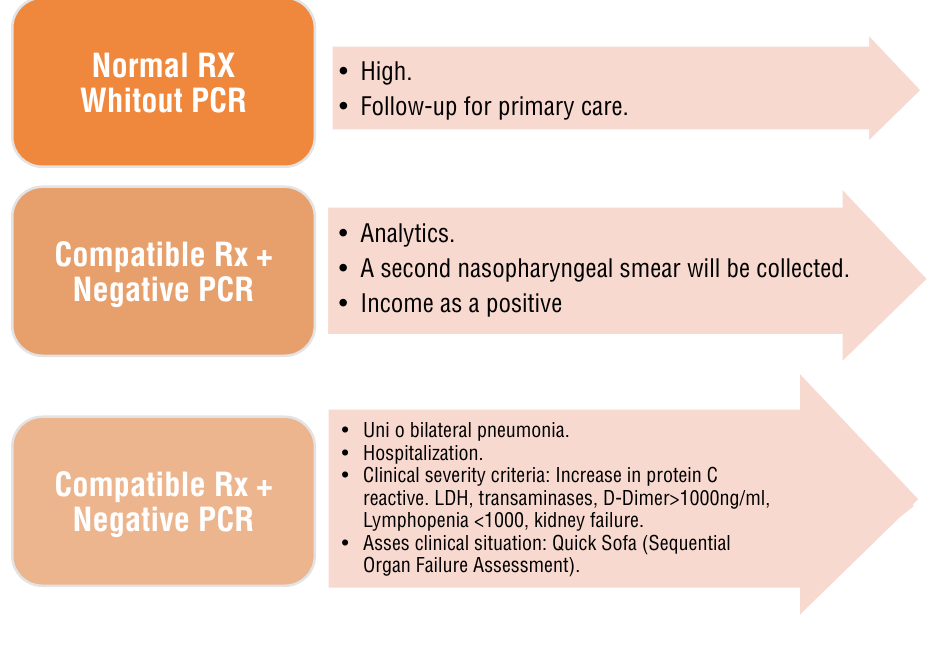
Figure 1 - Situations of chest X-ray and its performance in the emergency department. April